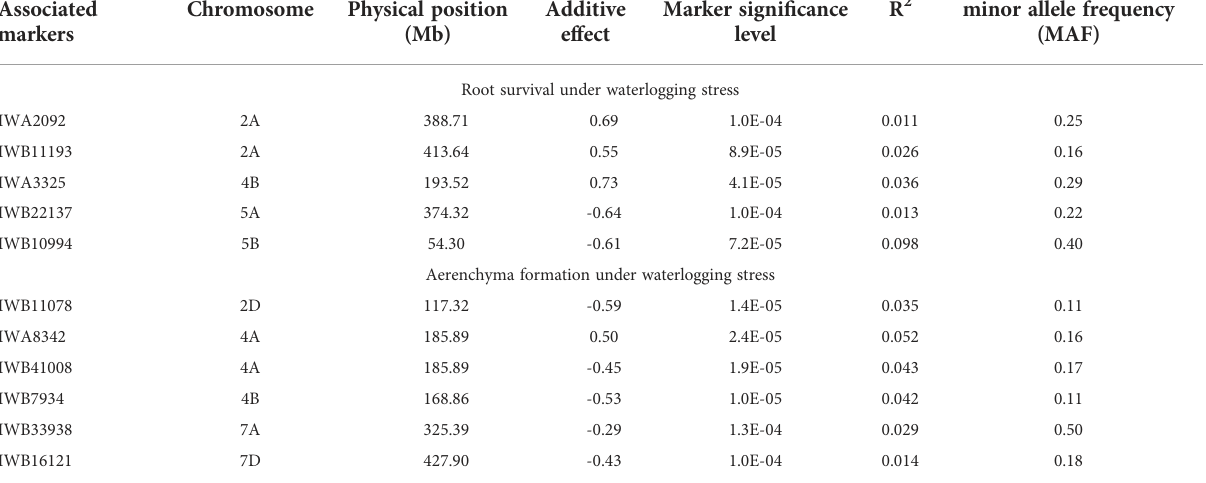
TABLE 1 QTL and associated markers for different traits. Associated markers